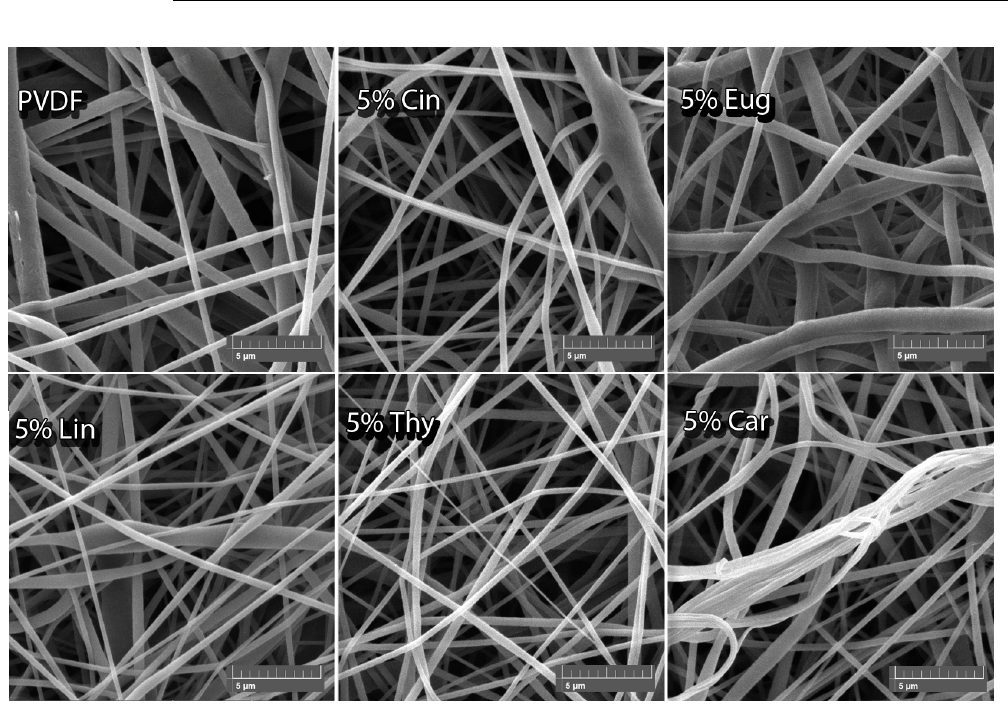
Figure 1. SEM images of PVDF pure nanofibers and ones loaded with 5% w / w of individual